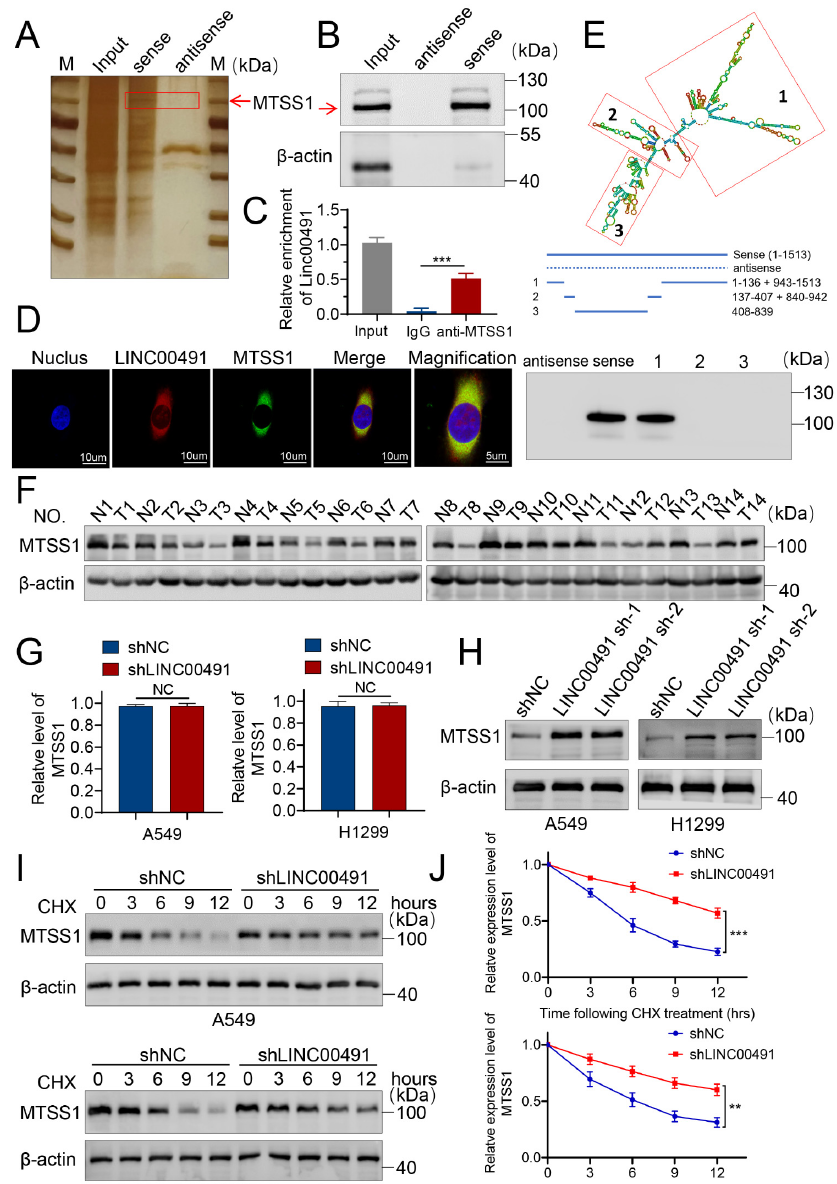
Figure 3. LINC00491 suppresses the expression of the MTSS1 protein by enhancing its degrada- tion. ( A ) Representative silver-stained gel of proteins pulled down by the sense and antisense of LINC00491. Mass spectrum was used to identify differentially exhibited lanes. ( B ) Western blot analysis of the pulldown product MTSS1. ( C ) RT-qPCR analysis of RIP. ( D ) Representative images of the colocalization of LINC00491 with MTSS1 proteins were obtained using a confocal microscope, detected by FISH and IF assays in A549 cells. ( E ) Schematic diagram shows the domain truncation mutants of the LINC00491 sense strand (upper panel). Western blot (bottom panel) showed the MTSS1 protein in the immunoprecipitated complex pulled down by LINC00491 and its truncations. ( F ) Expression of MTSS1 in LUAD and matched normal lung tissues. ( G ) The expression levels of MTSS1 were evaluated in the shNC and shLINC00491 groups of A549 and H1299 using RT-qPCR. ( H ) The expression levels of MTSS1 protein were analyzed in the shNC and shLINC00491 groups of A549 and H1299. ( I ) Immunoblot detection of MTSS1 in the shNC and shLINC00491 groups treated with 25 µ g/mL CHX for 0, 3, 6, 9, and 12 h. ( J ) Analysis of the MTSS1 degradation rate. In each experiment, three replicates were conducted. Data are presented as the mean ± SD. **, p < 0.01; ***, p <